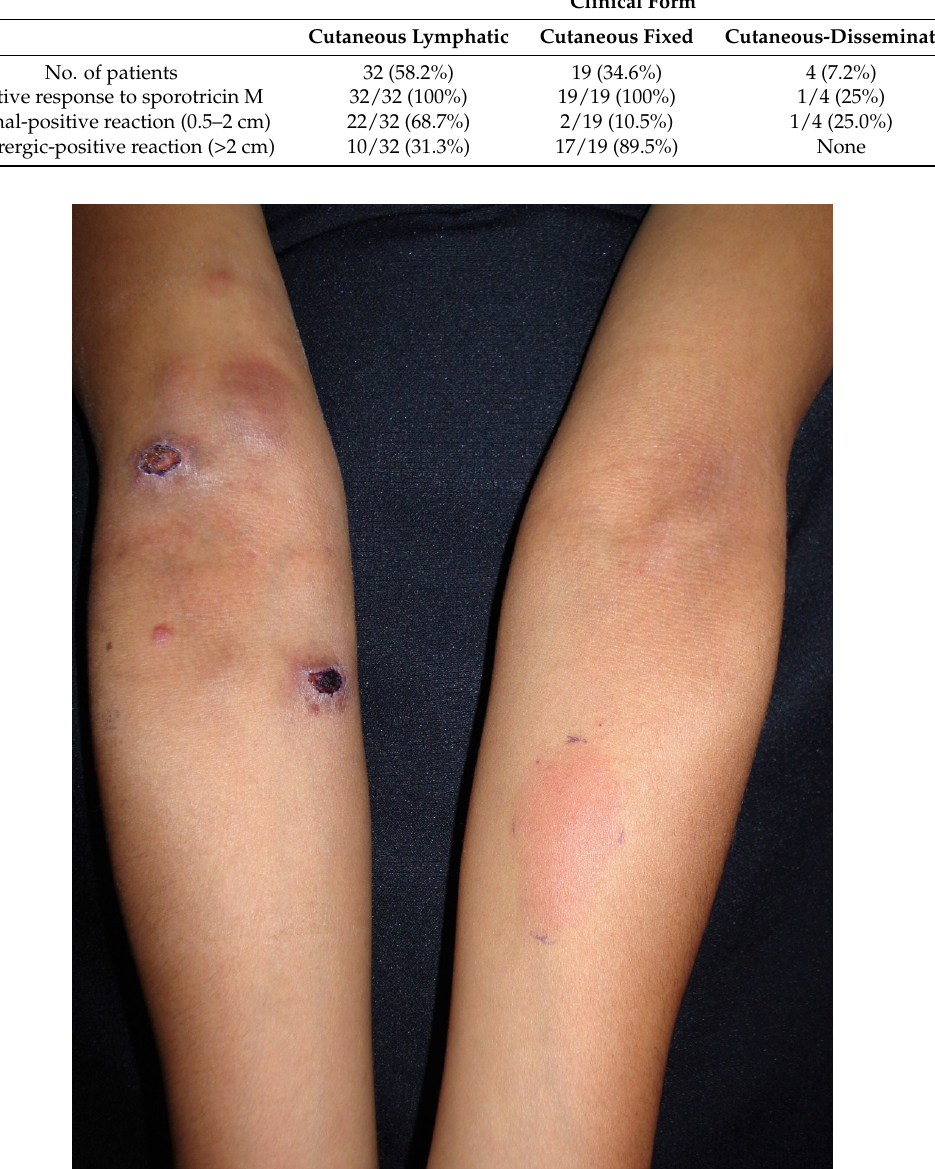
Table 1. Clinical types of sporotrichosis and response to the sporotrichin M skin test.